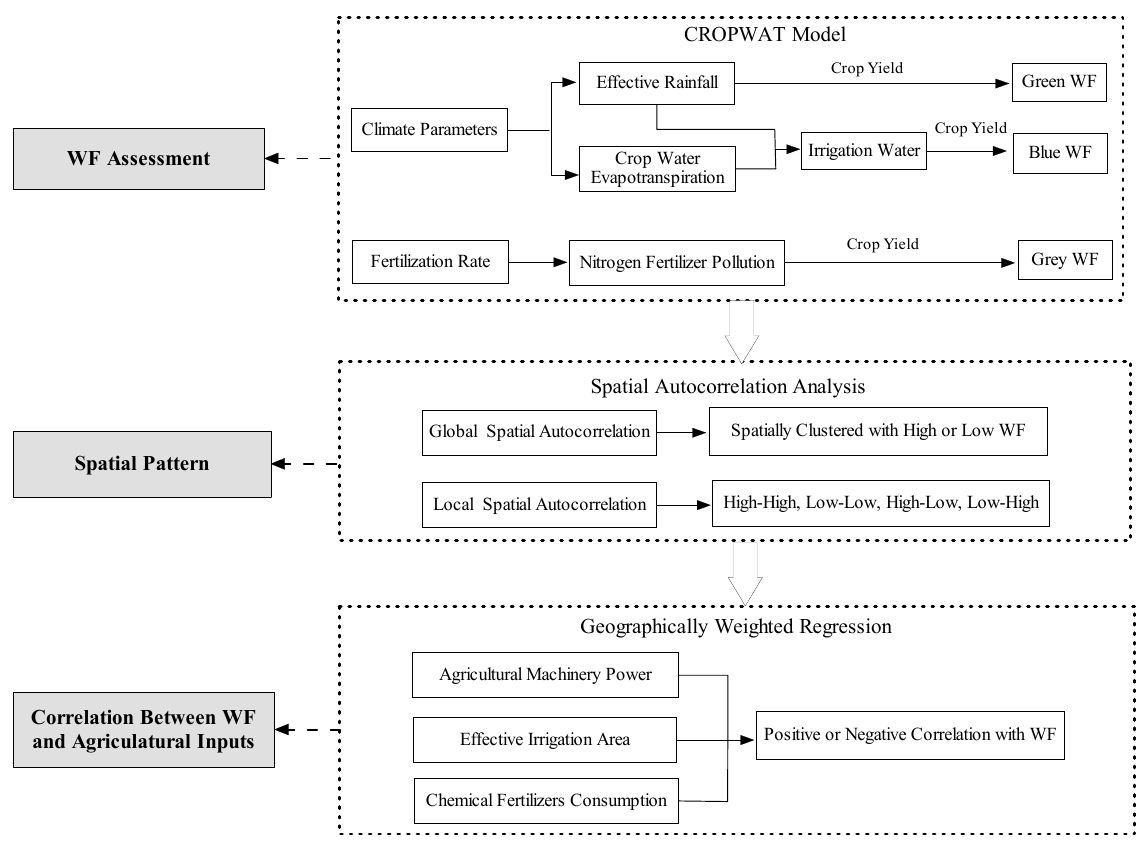
Figure 3. Diagram for WF assessment and the correlations between WF and agricultural